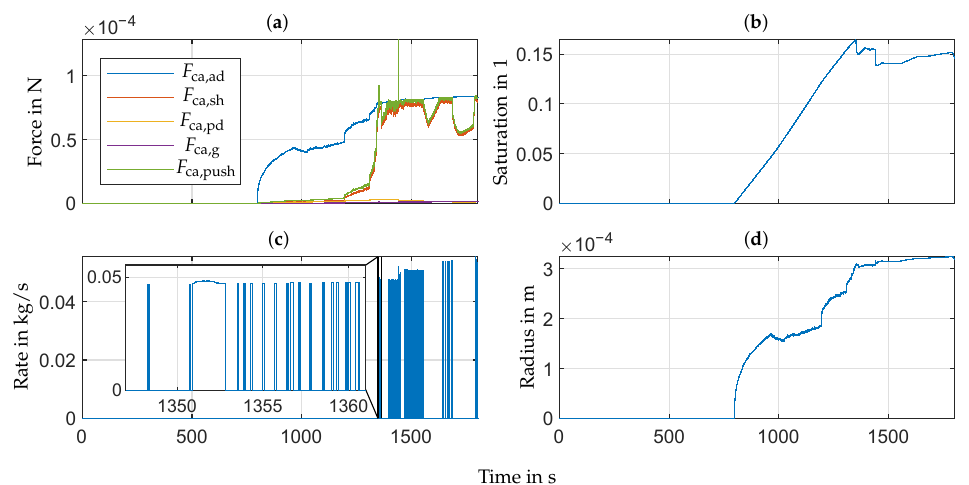
Figure 6. Insight into cathode droplet removal mechanisms. Plot ( a ): forces acting on a droplet over time. When pushing force F ca,push exceeds adhesion force F ca,ad , droplet removal occurs. Plot ( b ): reduced liquid water saturation s ca,red over time. It governs the droplet removal mechanisms, and in contrast to the liquid water saturation s ca , it takes the immobile saturation s im into account. Plot ( c ): droplet removal rate over time. When droplets detach according to the force balance, the droplet removal rate determines the outflow rate of liquid water, dependent on the average droplet volume. Plot ( d ): average droplet radius over time. The radius is a function of the reduced liquid water saturation and the current.